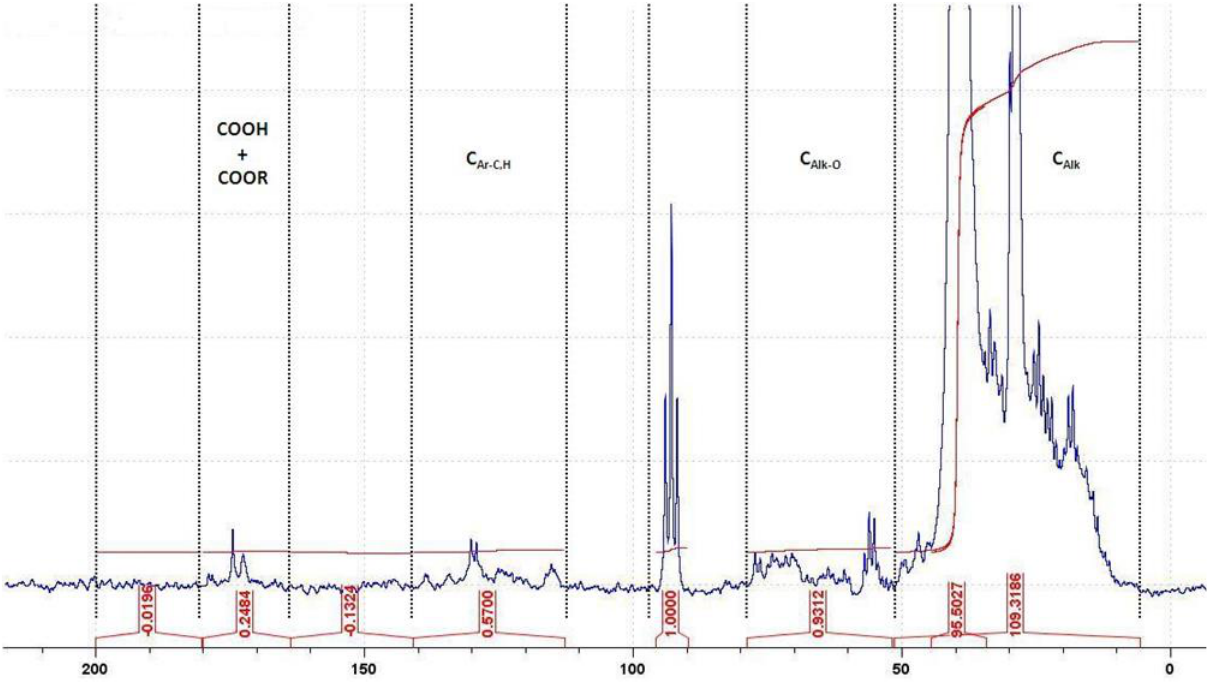
Figure A3. 13 C-NMR spectrum of bitumen in DMSO.